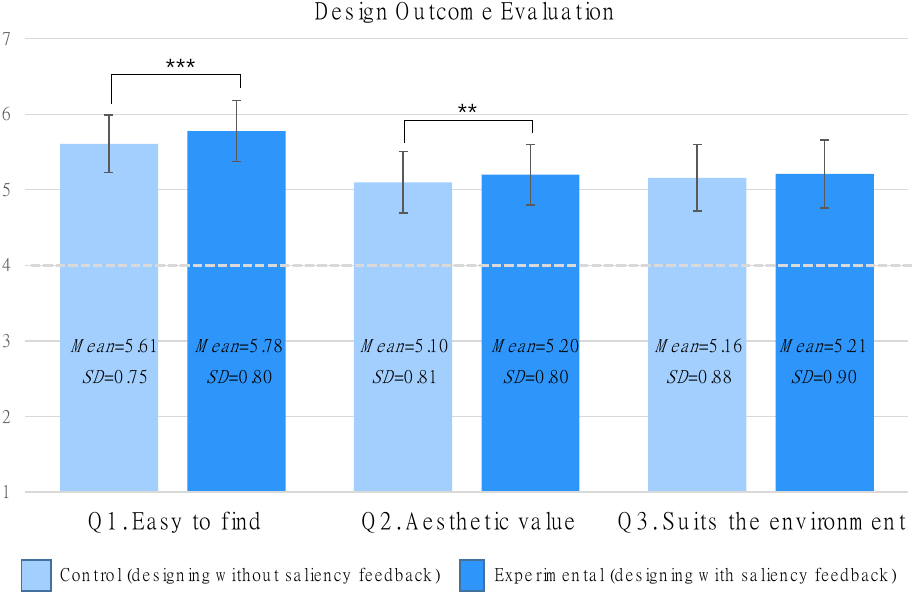
Figure 11. Perceived quality of signs produced with and without saliency feedback. Visual saliency helped to produce easier-to-find and more aesthetically pleasant designs (** p < 0.01, *** p < 0.001).